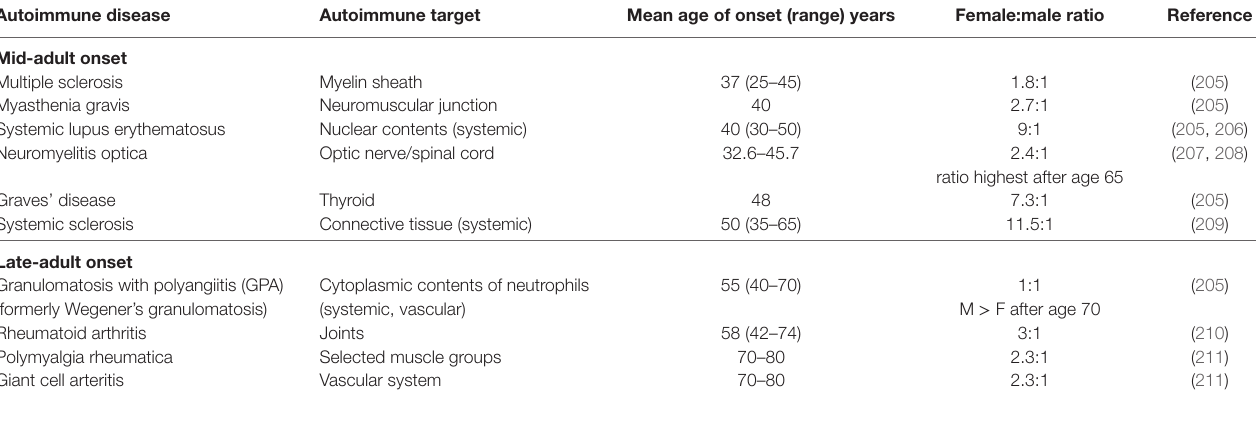
TABLe 2 | The female-to-male patient ratio for select mid-adult and late-adult onset autoimmune diseases. Autoimmune